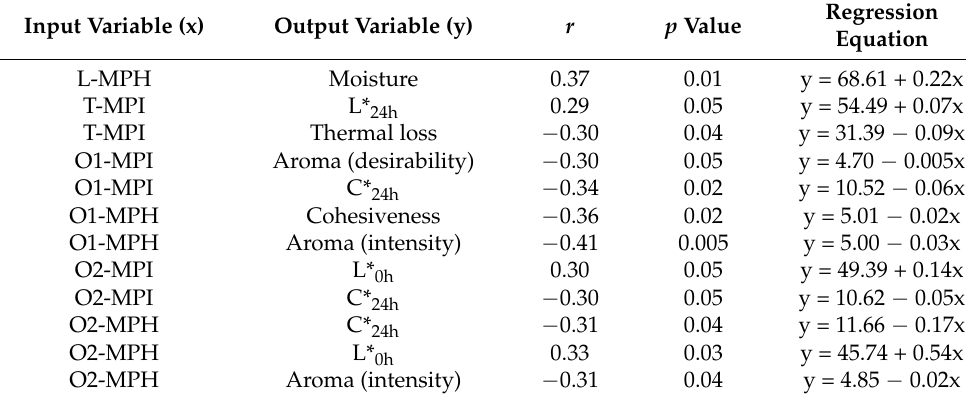
Table 8. Summary of significant correlations among echotextural variables and sen- sory/physicochemical characteristics of pectoralis major muscles recorded in organic turkeys; data were pooled for all birds